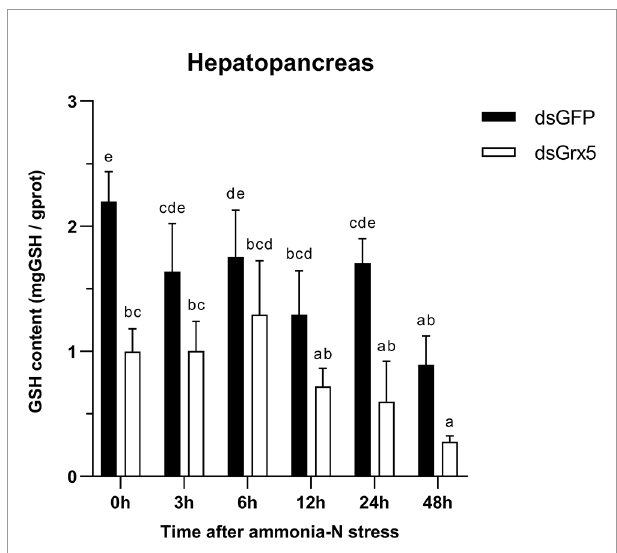
FIGURE 10 | Changes in GSH content in the hepatopancreas of dsRNA- injected shrimps under ammonia-N stress. The data are presented as mean ± SD ( n = 3). Different letters denote signi fi cant differences ( P < 0.05).